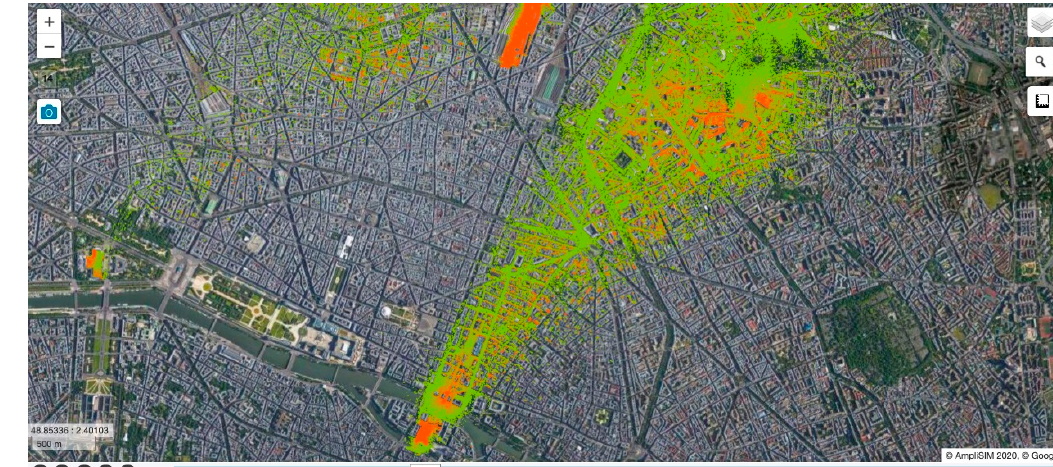
Figure 9. View of the three release locations and of the plumes, at the ground level, using tiled navigation. The threshold for 0.01 µg/m 3 of concentration is in green, while that for 1 µg/m 3 is in red (background satellite image © TerraMetrics, LLC—www.terrametrics.com © Google 2021, accessed on 30 April 2021).